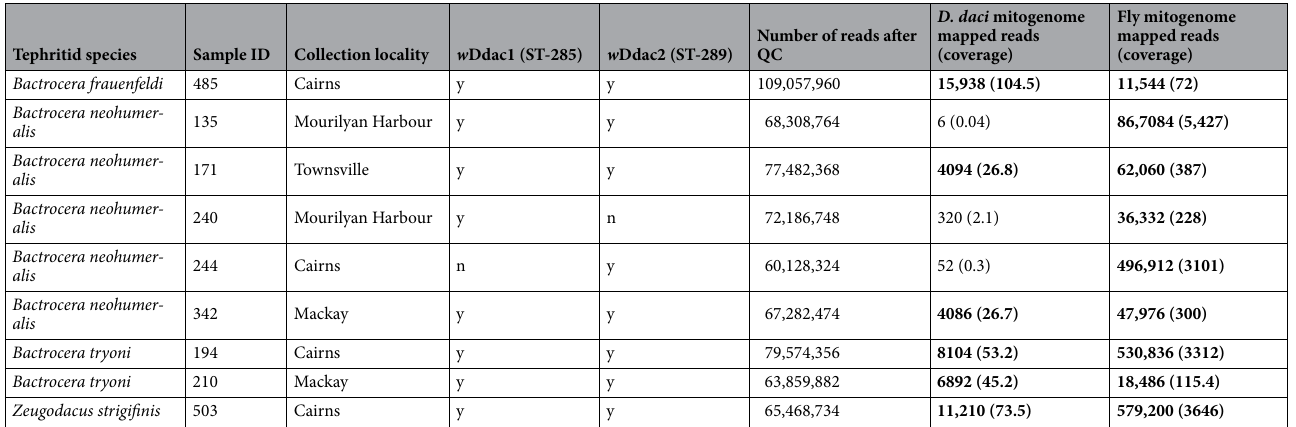
Table 1. Summary of nine fruit fly WGS libraries obtained from individuals of four tephritid fruit fly species parasitised by Dipterophagus daci , collection localities, Wolbachia infection status (+ or −) with w Ddac1 (ST- 285) and w Ddac2 (ST-289), number of reads after QC and coverage for the D. daci and fruit flies mitogenomes. Mitogenomes with high coverage are presented in bold, with coverage number in parentheses. All nine fruit fly samples contained D. daci as detected by sequence reads and PCR 47